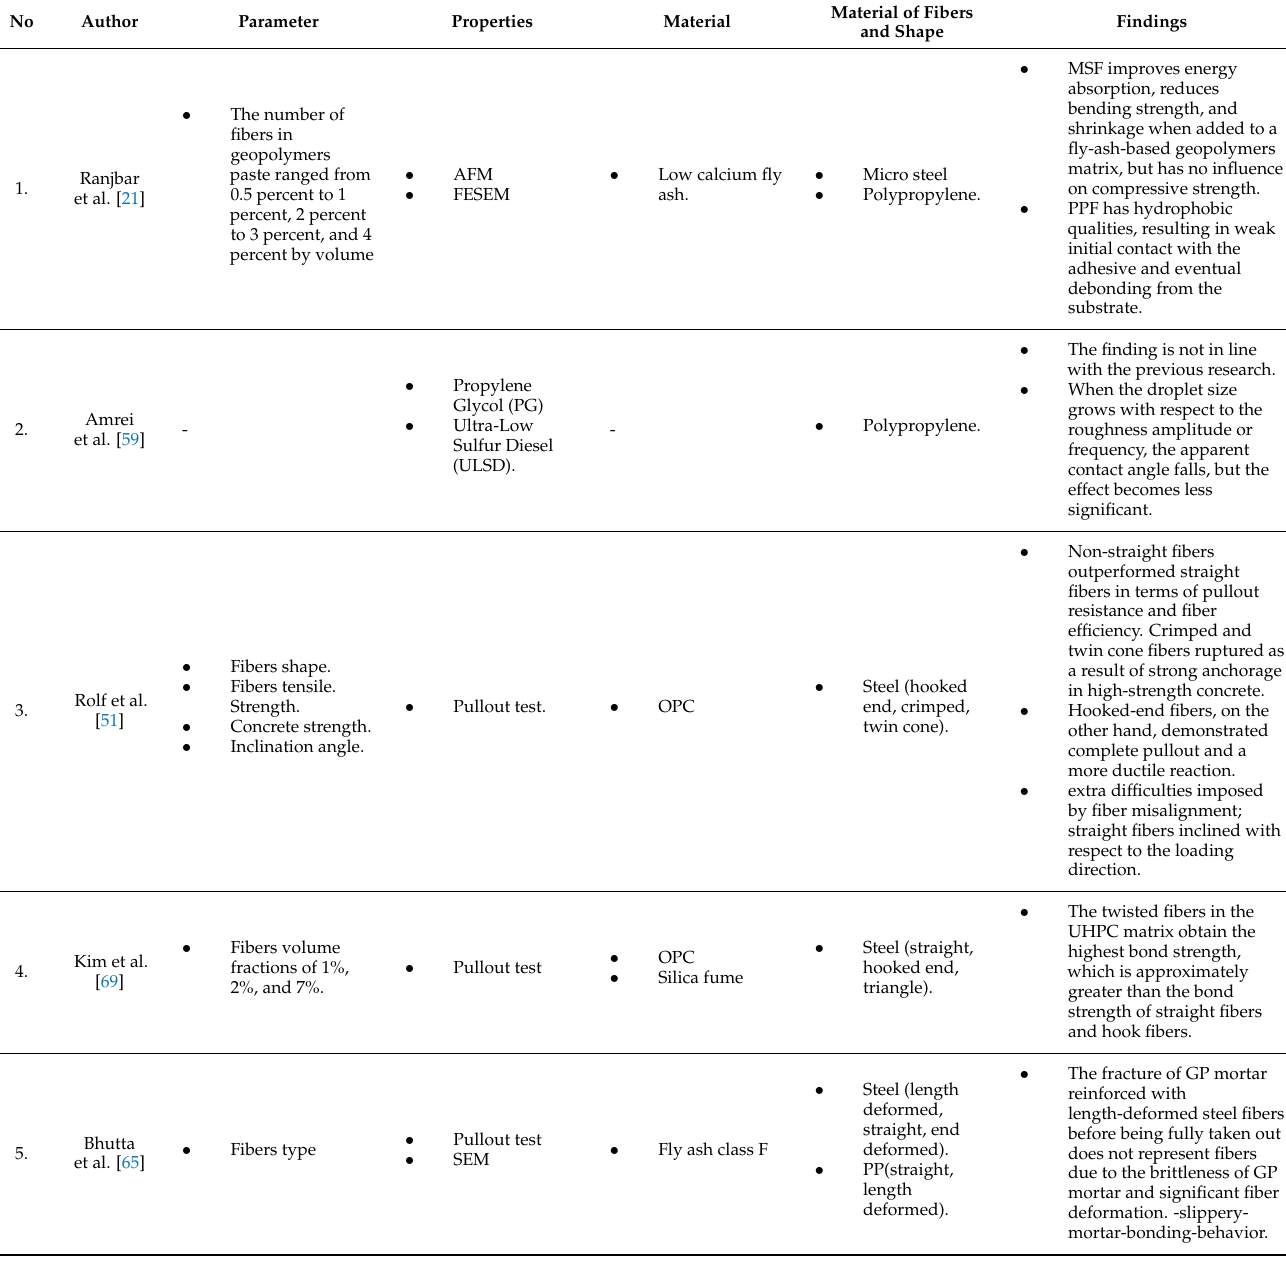
Table 2. Research on the bonding between matrix and